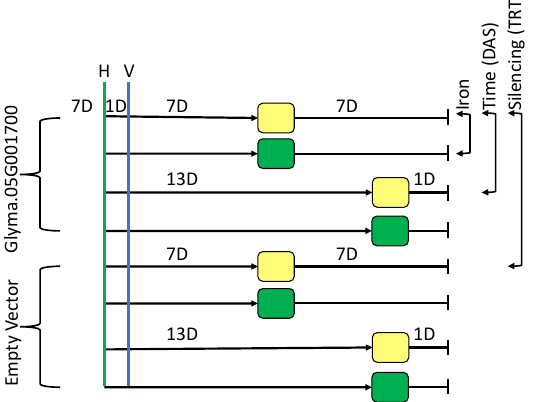
Figure 1. Experimental Design. Soybean plants were germinated in vermiculite. At 7 days (7D) after planting, plants were transferred to a hydroponic system, denoted by H and green vertical line. After 24 h in hydroponics, plants were rub-inoculated with VIGS virus containing either empty vector or vector to silence Glyma.05G001700, denoted by V and vertical blue line. Plants were grown in optimal hydroponic conditions for either 7D or 13D. Half of plants moved at each timepoint were transferred to new sufficient (green) or iron deficient (yellow) conditions. Examples of the three types of comparisons made are denoted on the right.